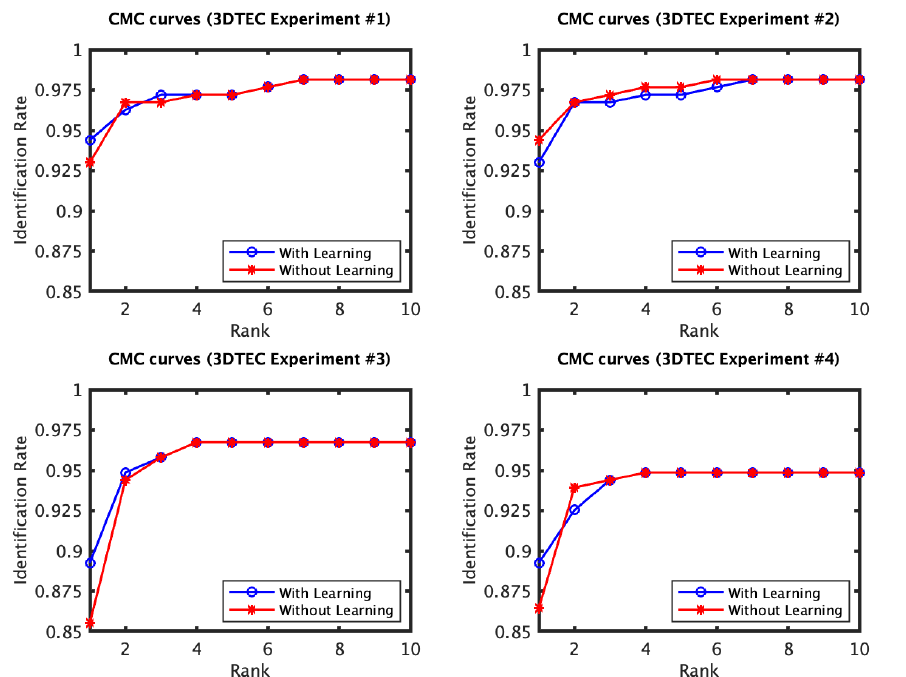
Figure 5. The CMC curves of the four experiments of the 3D TEC dataset performed using RAIK descriptor. The first two experiments involve no expression variations. For these two experiments there is a limited effect of the learning approach on the identification performance. In contrast, the third and fourth experiments have expression variations among the twins facial scans, for which the proposed approach has shown to considerably improve the recognition performance.